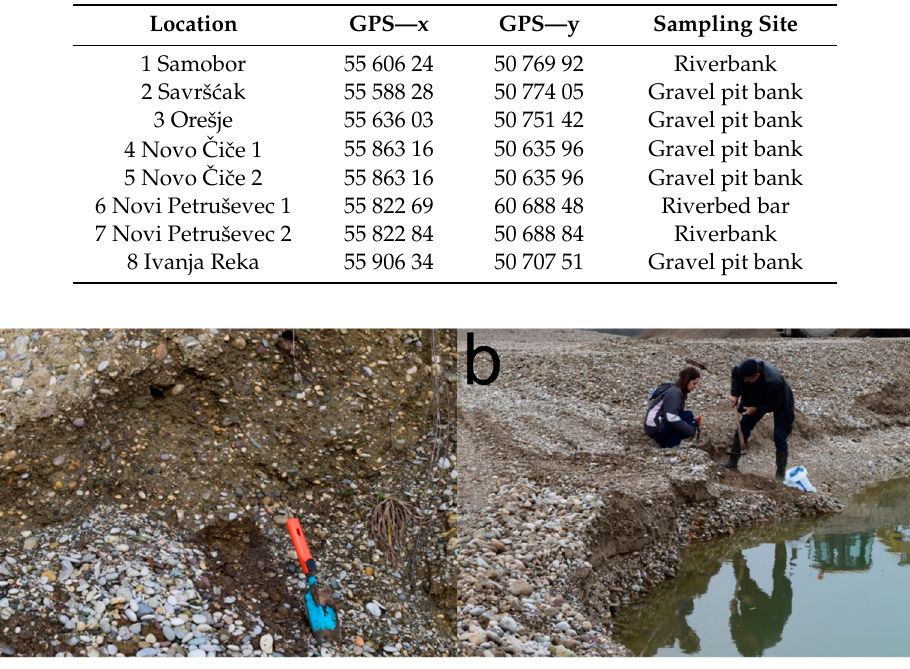
Table 1. Investigated locations, GPS coordinates, and sampling sites.